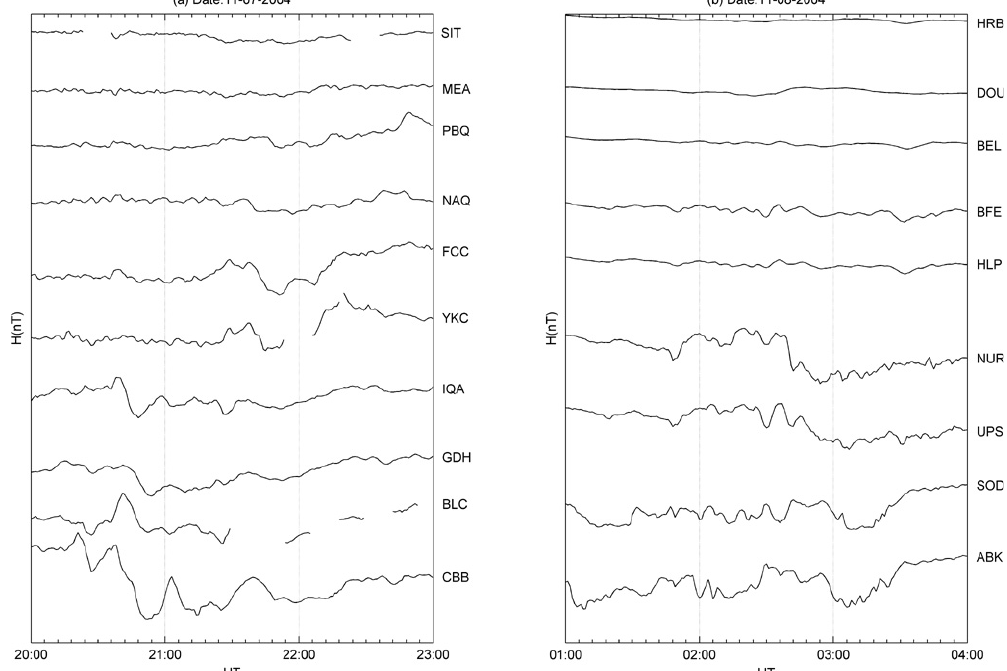
Fig. 6. Time dependence of the magnetic H component during 20:00 ∼ 23:00UT on 7 November in North America (a) and 01:00 ∼ 04:00UT on 8 November in Europe (b) at the geomagnetic observatories, respectively. The code name of each geomagnetic observatory was marked nearby.